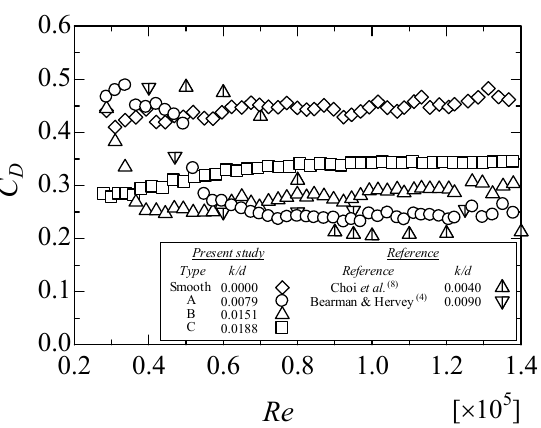
Fig. 3 Dependence of drag coefficient on Reynolds